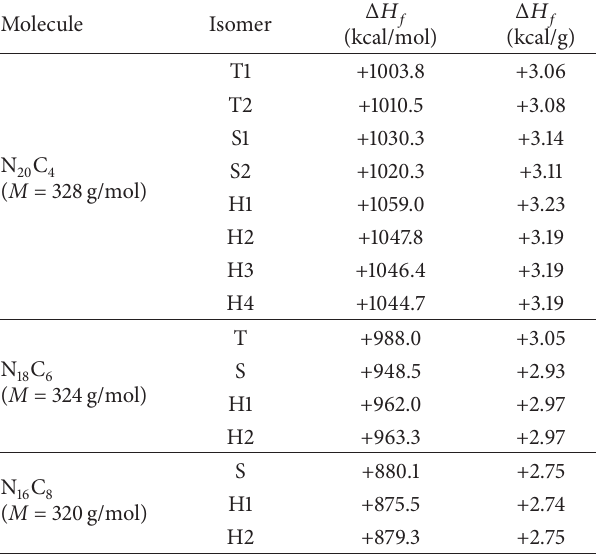
Table 1: Relative energies of N All energies are calculated with cc-pVDZ basis set. Energies are in kcal/mol. Point group symmetries of each isomer are listed with the isomer name.